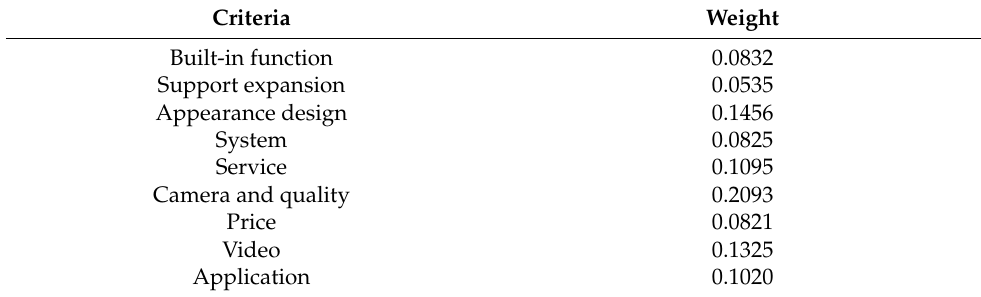
Table 6. The word of mouth weight.